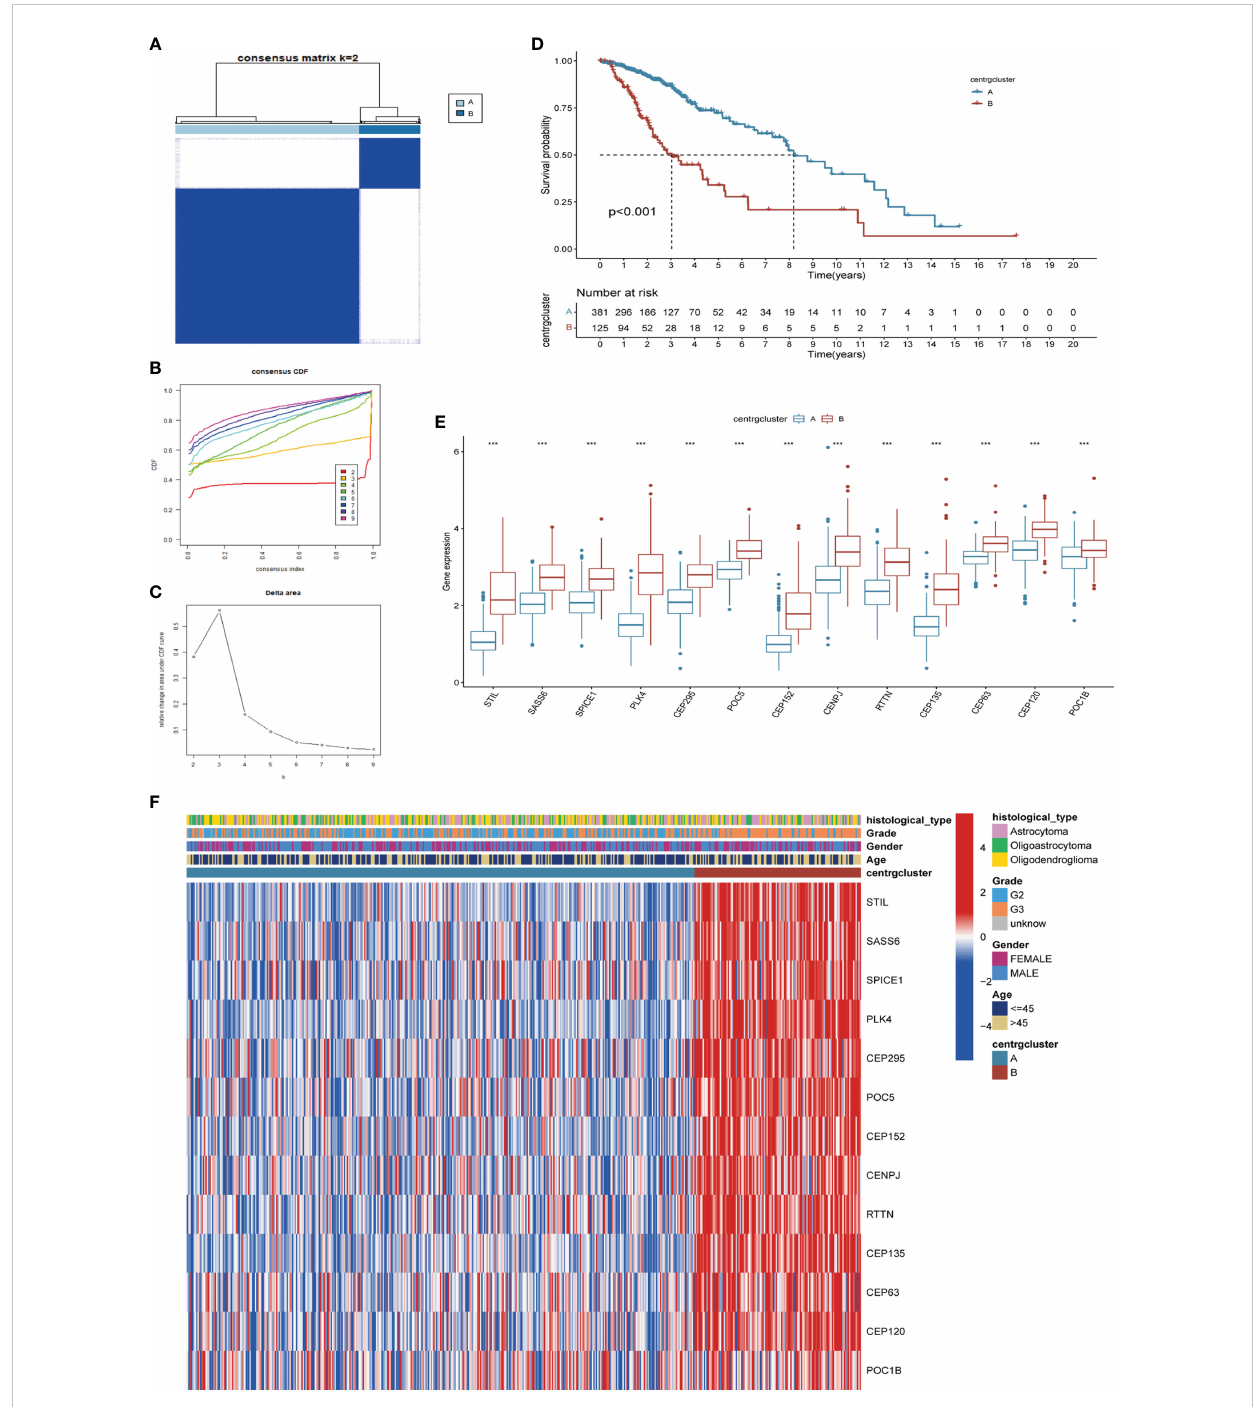
FIGURE 3 Identi fi cation of CRGs subtypes and exploration of the clinical and biological features of subtypes. (A) Unsupervised consensus clustering divides LGG samples into two clusters (k=2). Detailed of consensus clustering to identi fi cation of CRGs subtypes: cumulative distribution curve (B) and area under the cumulative distribution curve (C) . (D) OS curves of patients with two subtypes of LGG. (E) Differential expression of CRGs in different subtypes. (F) Clinicopathological characteristics and CRGs expression of two distinct subtypes. CRGs, centrosome related genes; ***p <